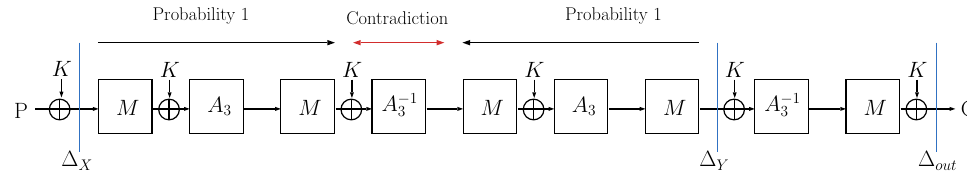
Figure 11: Impossible differential on a reduced version of MOE with 4 non-linear